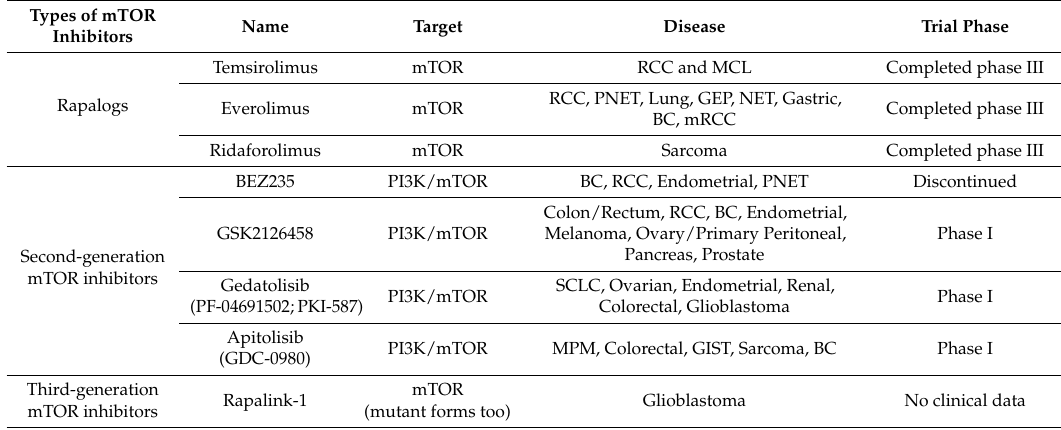
Table 2. Mechanistic target of rapamycin (mTOR) inhibitors used in the